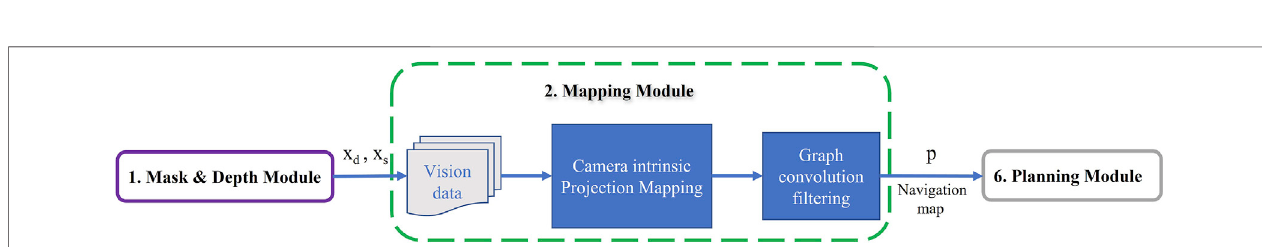
FIGURE 4 | Mapping Module: Given depth map and segmentation mask, this module creates a projection (BEV) map and then it re fi nes the map using the trained graph convectional network. The generated navigation map will be used further in the Planning Module.